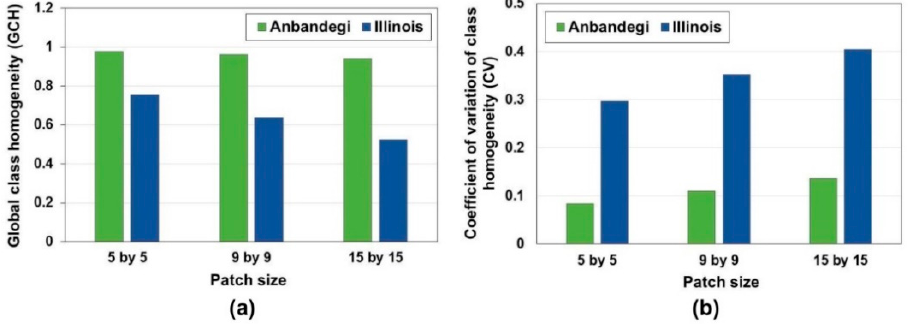
Figure 5. Variation in ( a ) global class homogeneity (GCH) and ( b ) coe ffi cient of variation of class homogeneity (CV) of two study regions.